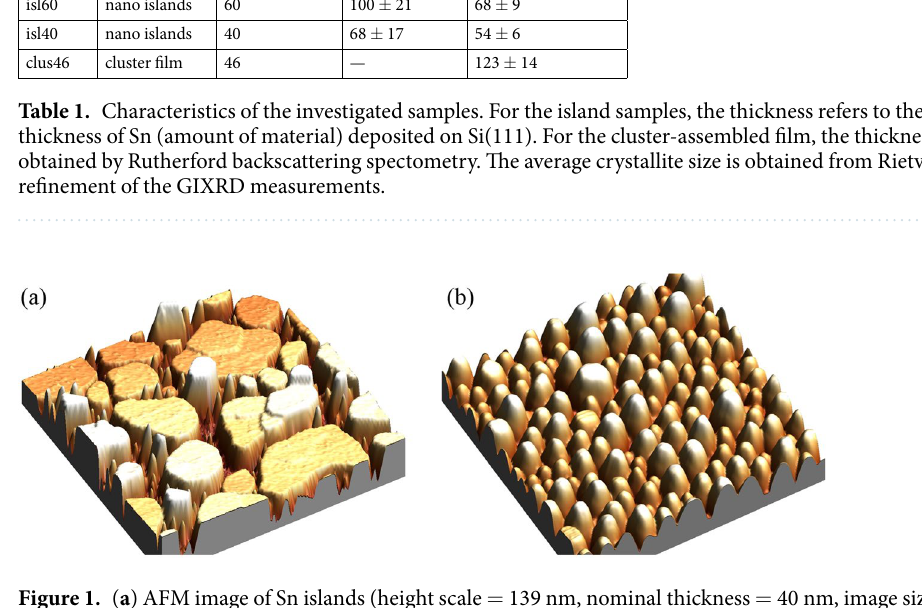
Figure 1. ( a ) AFM image of Sn islands (height scale = 139 nm, nominal thickness = 40 nm, image size = 7 μ m × 7 μ m) ; ( b ) AFM image of Sn cluster-assembled film, (height scale = 53 nm, thickness = 50 nm, image size = 1 μ m × 1 μ